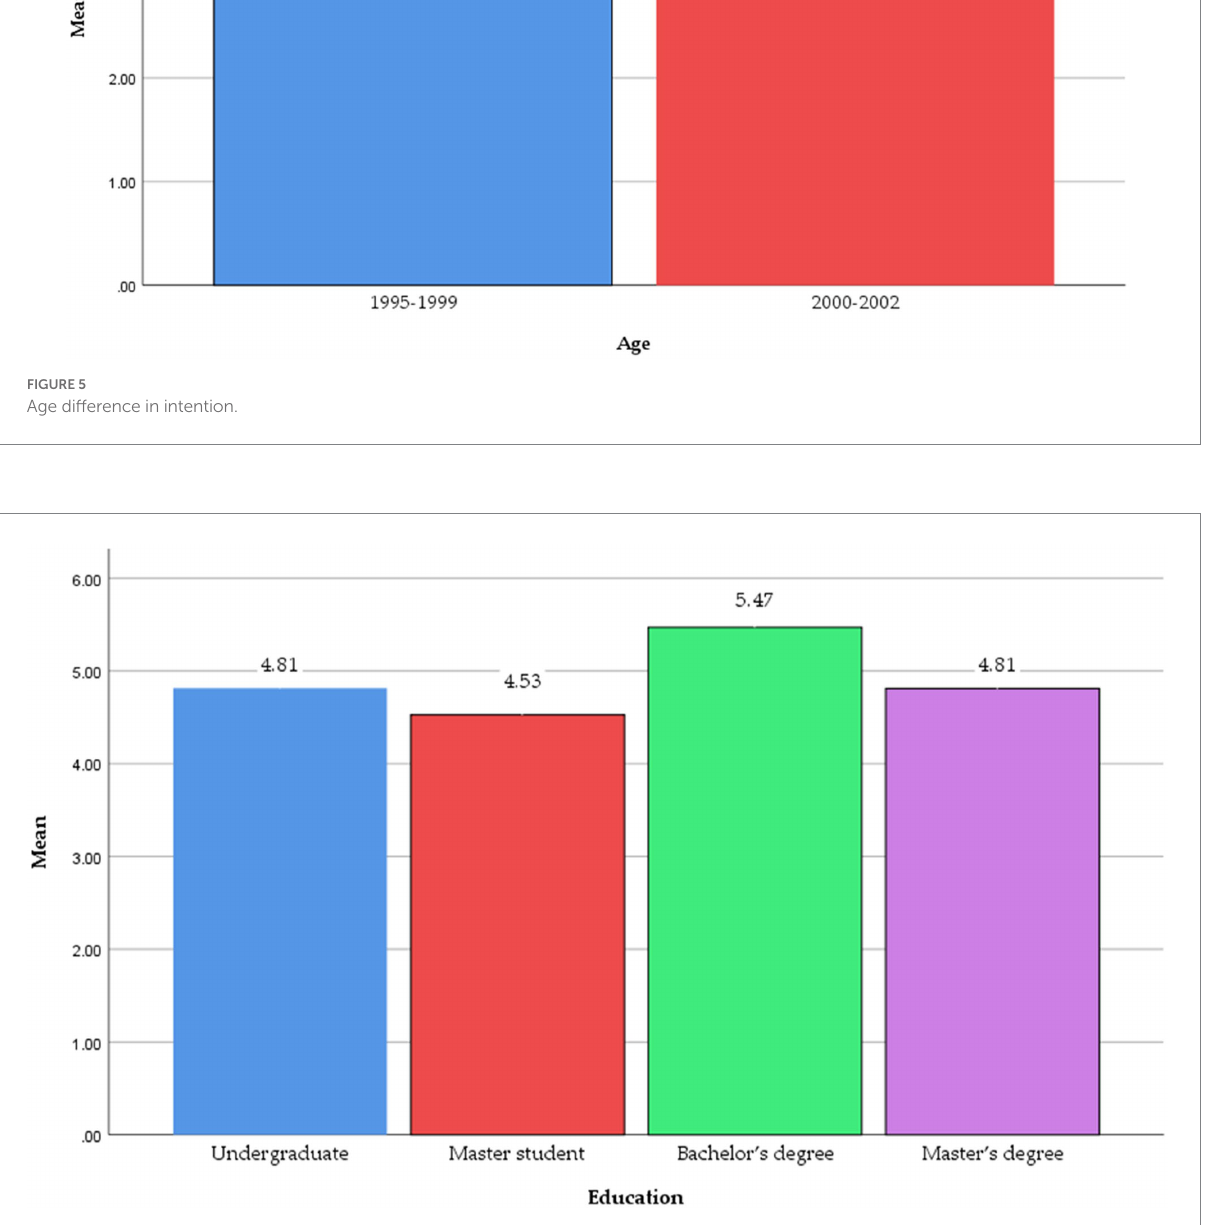
FIGURE 6 Education difference in